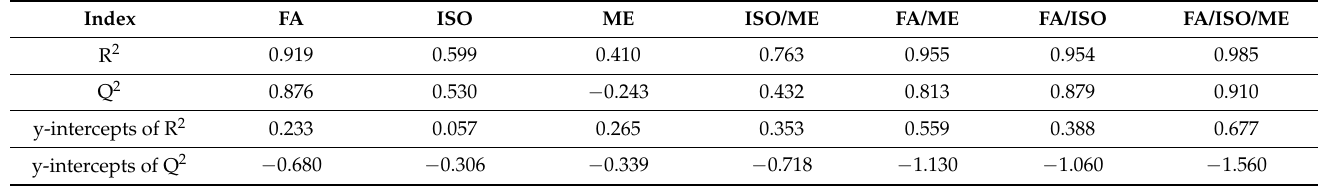
FA = Fatty acid; ISO = Isotope; ME = Mineral elements; R 2 = the measure of the fit of the model; Q 2 = the measure of predictive ability of the